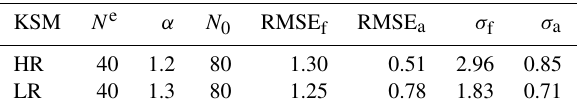
Table 3. Same as Table 2, but using KSM deduced from experi- ments in Fig.